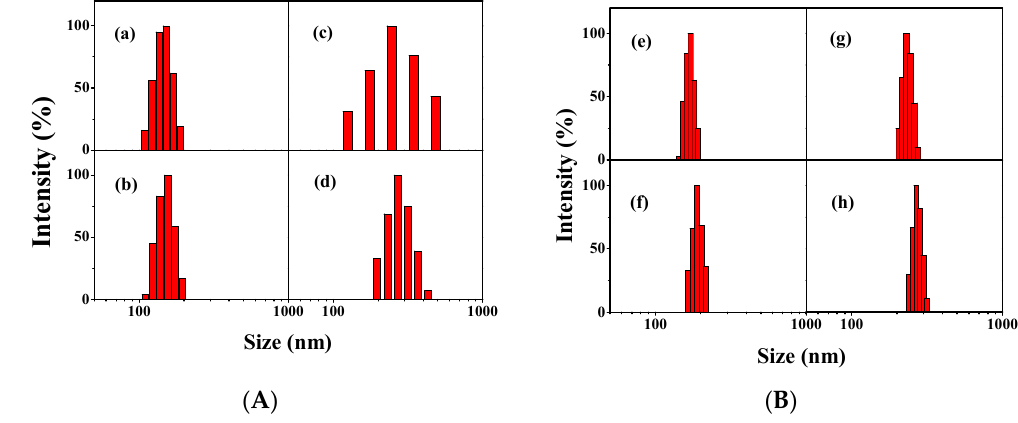
Figure 5. Particle-size distribution of micelles in PBS. ( A ) CA-CP, ( B ) CA-CDEP; ( a , e ) for blank micelles at 7.4; ( b , f ) for blank micelles at 5.0; ( c , g ) for drug-loaded micelles 3/10; ( d , h ) for drug-loaded micelles 5/10.